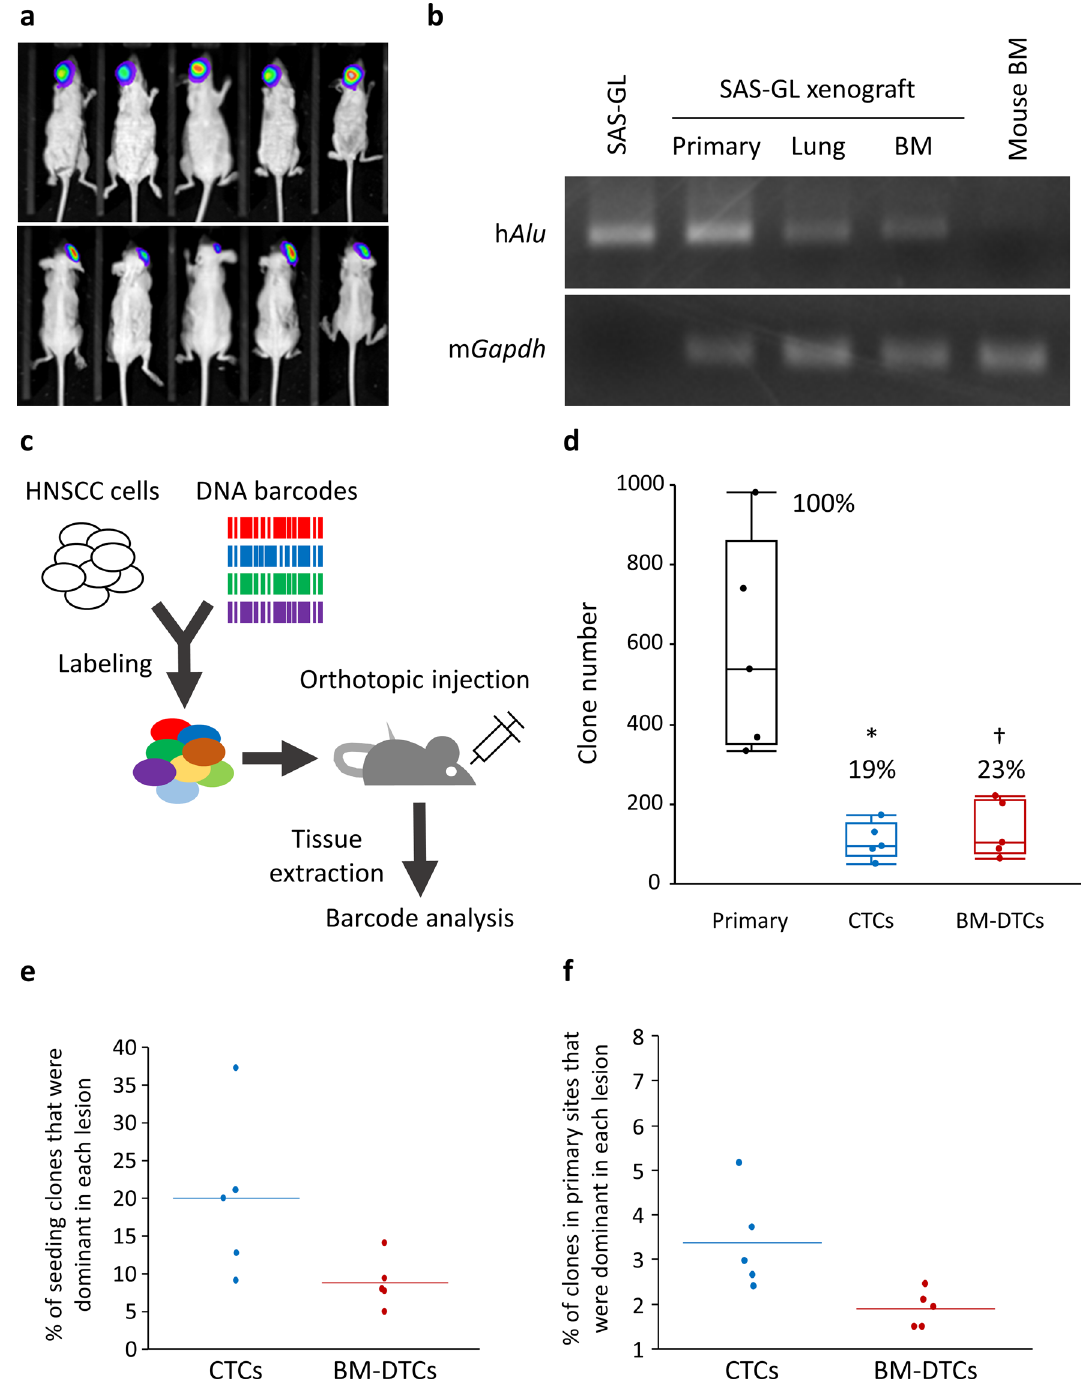
Figure 1. A limited number of clones dominates CTCs and DTCs. ( a ) Representative ventral (upper panels) and dorsal (lower panels) bioluminescent images of mice 30 days after orthotopic injection of SAS-GL cells. ( b ) Representative data for human Alu (h Alu ) sequence amplification 30 days after orthotopic injection of SAS-GL cells that indicated SAS-derived DTC presence. Cultured SAS-GL cells (left end) and BM from nontransplanted mice (right end) were controls. m Gapdh , mouse Gapdh . Uncropped gels can be found in Supplementary Information. ( c ) Lentiviral barcode strategy for identifying clonal populations in SAS cells. ( d ) Unique seeding clones in the primary tumor, CTCs, and BM-DTCs were quantified and plotted. Above the bars are the percentages of unique clones in each organ site and the primary tumor. Values are means ± SEM ( n = 5 mice), * p < 0.005; † p < 0.01 (two-tailed t tests). ( e ) Percentages of dominant clones (top 75%) relative to the total number of seeding clones in each lesion. ( f ) Percentages of dominant clones (top 75%) in each lesion relative to the total number of unique clones in the primary